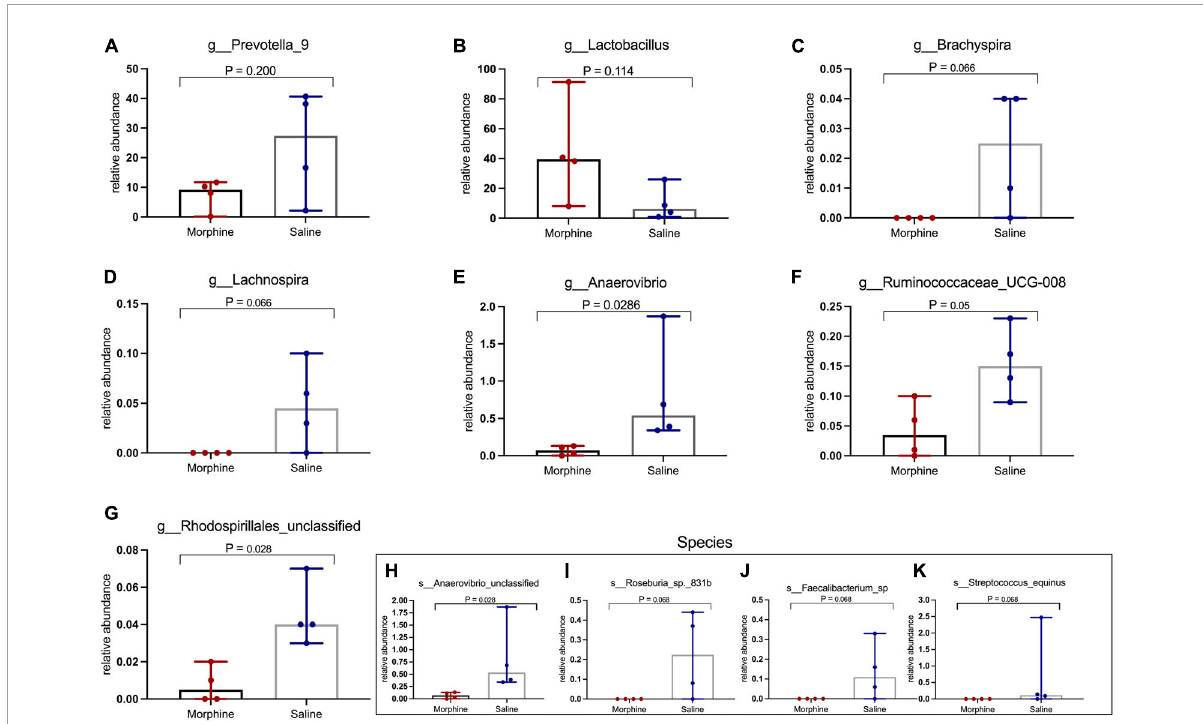
FIGURE6 In simian human immunodeficiency virus (SHIV) infected rhesus macaques, exposure to morphine leads to reduced distinct genera and species of the fecal microbiota. Genus and Species differences within the fecal microbiomes as detailed by (A) Prevotella-9 genus, (B) Lactobacillus genus, (C) Brachyspira genus, (D) Lachnospira genus, (E) Anaerovibrio genus, (F) Ruminococcaceae UCG-008, (G) Rhodospirillales unclassified, (H) Anaerovibrio species, (I) Roseburia_sp_831b , (J) Faecalibacterium species, (K) Streptococcus equinus species of SHIV + morphine animals vs. SHIV + saline rhesus macaques. [ p < 0.05 deemed significant while borderline significance ( p = 0.05 to p = 0.07), all obtained using the Mann–Whitney U -test for non-parametric differences within the two classified